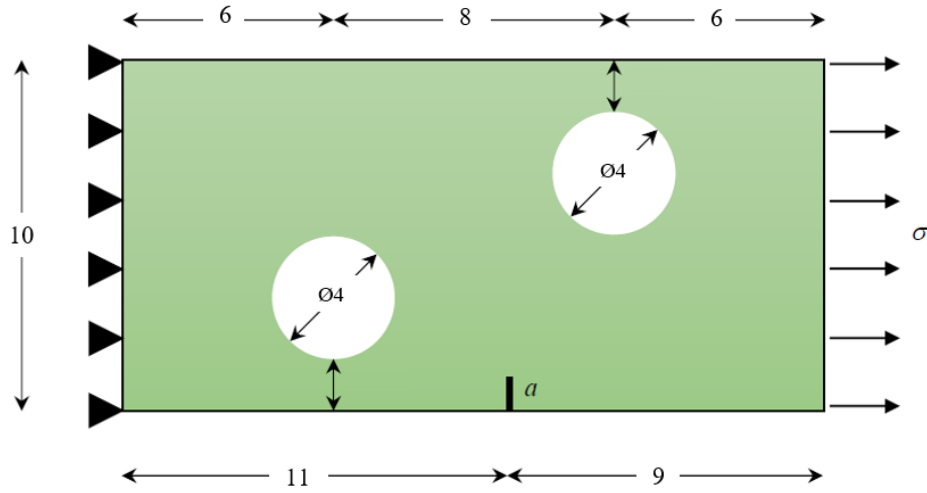
Figure 6. Initial adaptive mesh of the rectangular structure with two holes and one central crack.